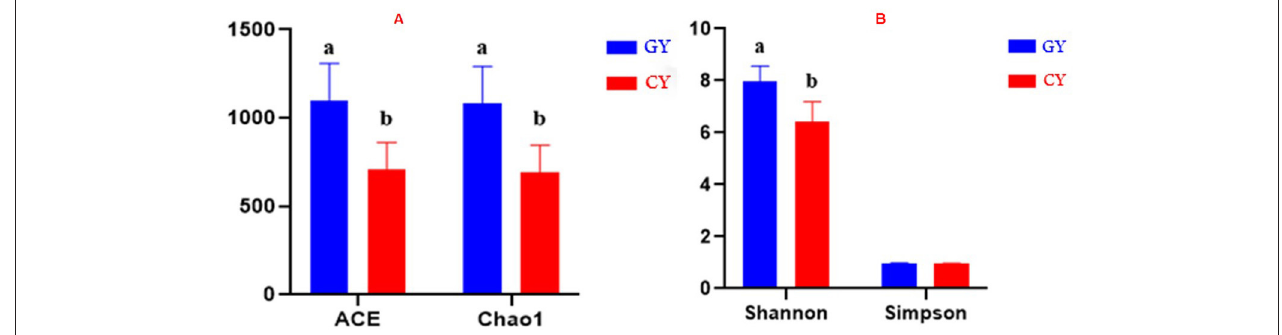
FIGURE 2 | Principal coordinates plot of OTU-level weighted UniFrac distance among grazing (GY) and feedlots (FY) yak groups.